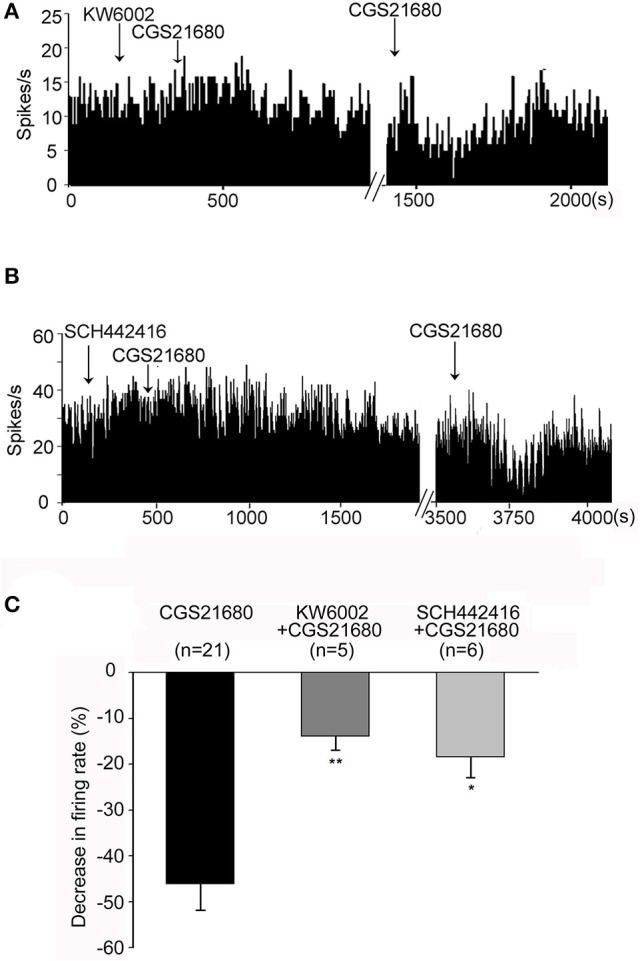
Both KW6002 and SCH442416 blocked CGS21680-induced decrease in firing rate. (A) Typical frequency histograms showing that application of 1 μM CGS21680 in the presence of 1 μM KW6002 did not change the firing rate. However, the second time application of CGS21680 alone significantly decreased the firing rate in this neuron. (B) Typical frequency histograms showing that 1 μM SCH442416 blocked 1 μM CGS21680-induced decrease in firing rate. (C) Pooled data summarizing the effects of both KW6002 and SCH442416 on CGS21680-induced decrease of firing rate. The black bars represent the effects of CGS21680 alone, while the dark gray bars and light gray bars represent effects of CGS21680 together with KW6002 or SCH442416, respectively. *P < 0.05, **P < 0.01, compared to CGS21680 alone group, Mann-Whitney test.